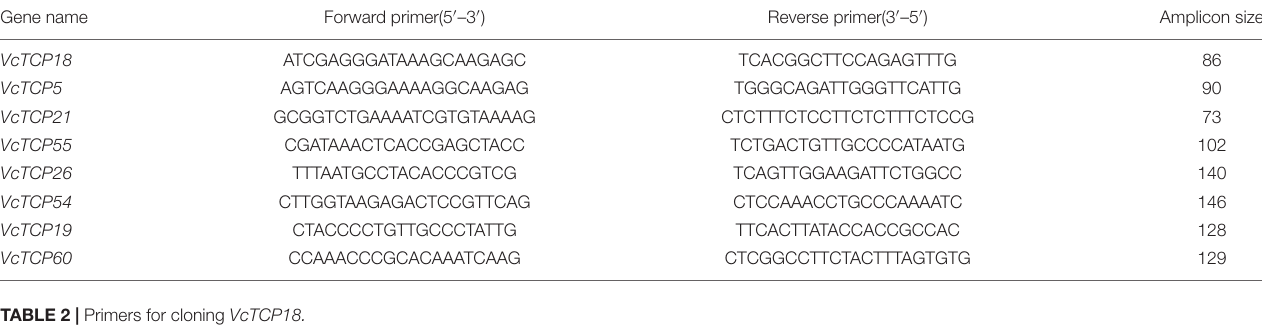
TABLE 1 | The primers used for qRT-PCR in the study.